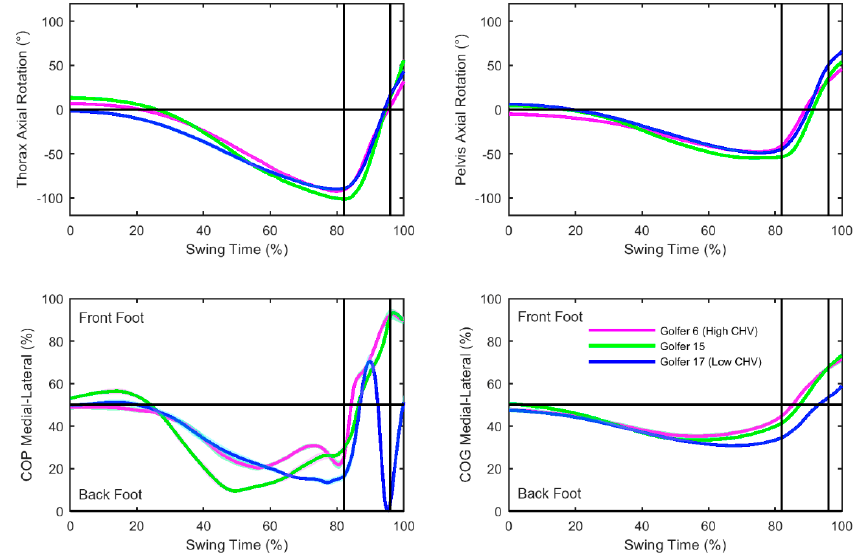
Figure 6. Examples of mean ± SD of biomechanics variables for a golfer from quadrant one (Q1) (Golfer 7, purple line, mean ± SD clubhead velocity = 49.7 ± 0.5 m·s − 1 , ball velocity = 70.7 ± 1.1 m·s − 1 ) and quadrant two (Q2) (Golfer 20, green line, mean clubhead velocity = 44.9 ± 0.3 m·s − 1 , and ball velocity = 65.9 ± 0.4 m·s − 1 ). Vertical lines represent top of backswing and impact, respectively.